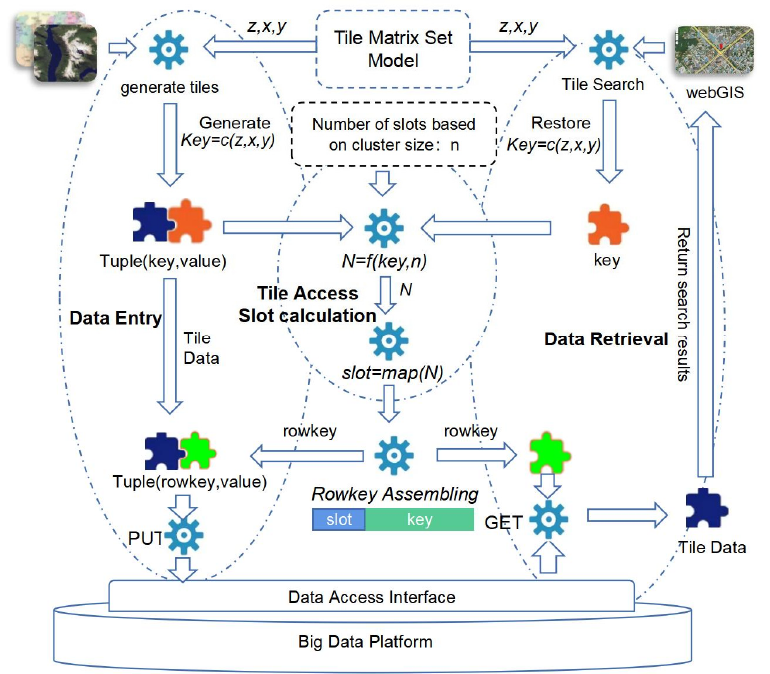
Figure 2. Access model for tile data in HBase.